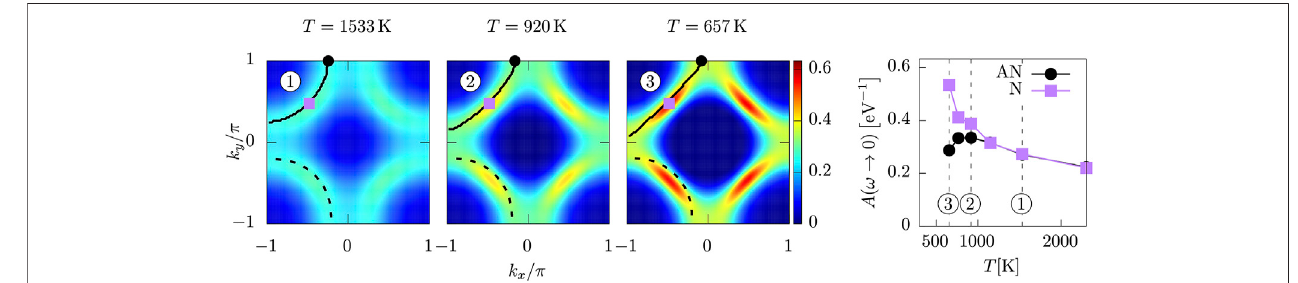
FIGURE3| Spectral intensities A ( k , ω =0)foraconstantdopingof7.5%andtemperaturesof1533K,920K,and 657K,calculatedbyD Γ A.Theblacklines indicate theFermisurfacesofthenon-interactingcase(dashed)andinteractingcase(solid)[forincreasedreadability,theseareonlyshownforonequadrantoftheBrillouinzone]. The nodal (purple square)-antinodal (black circle) differentiation of the spectral weight together with the suppression of it at the antinode (right-hand panel) is a clear indication of a pseudogap.